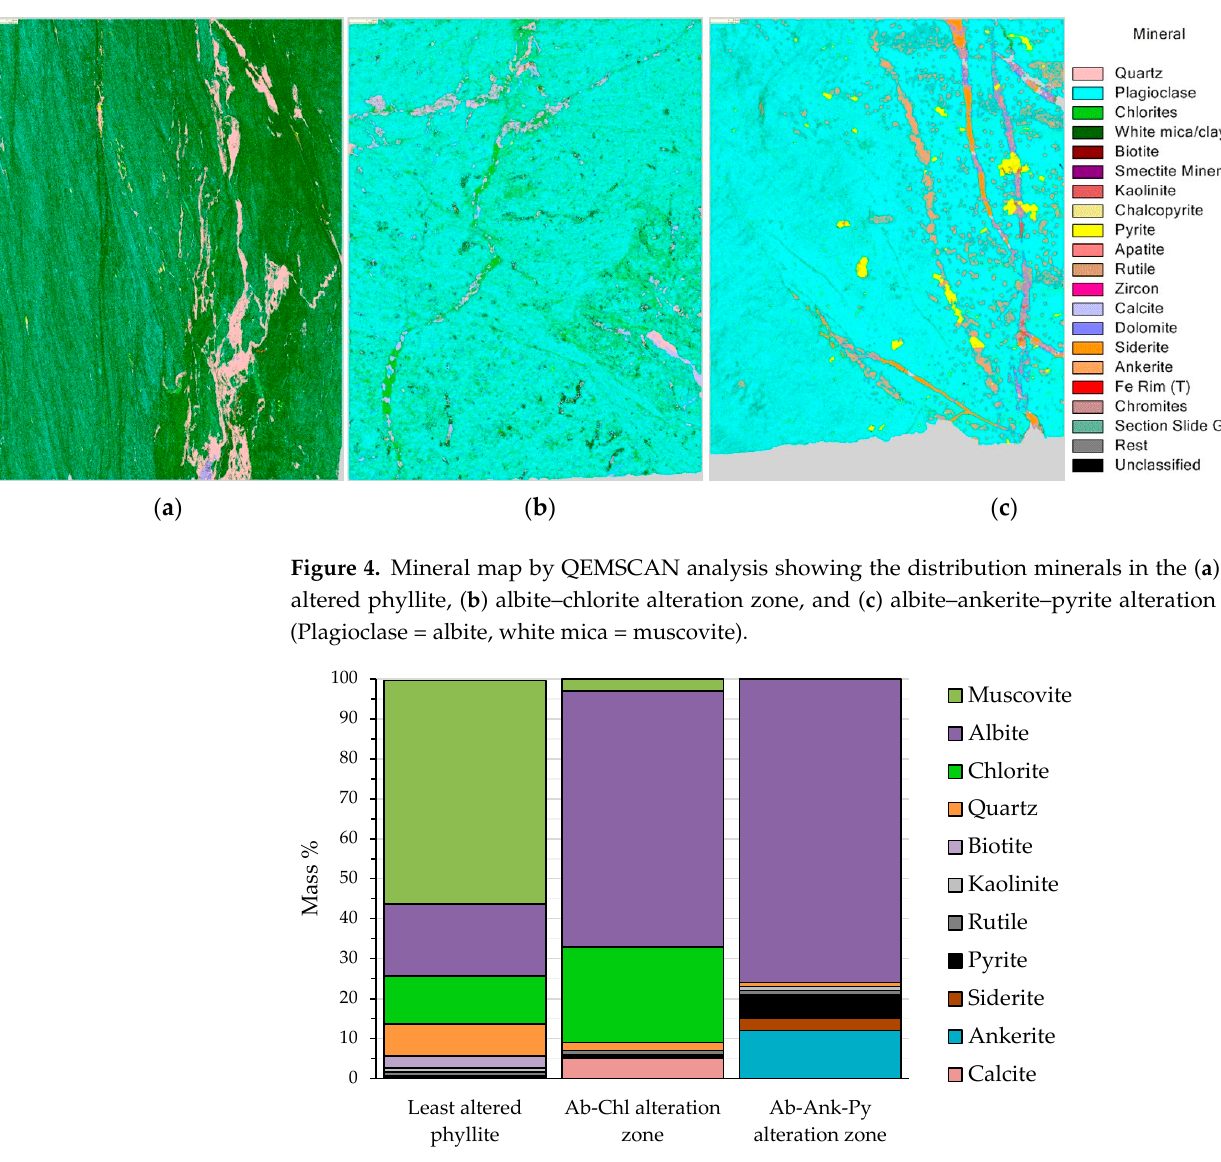
Figure 5. Mineral assembly in alteration zones. (Abbreviations: Ab = albite, Ank = ankerite, Chl = chlorite and Py = pyrite). Table 1. Mineral quantification from different alteration zones measured by